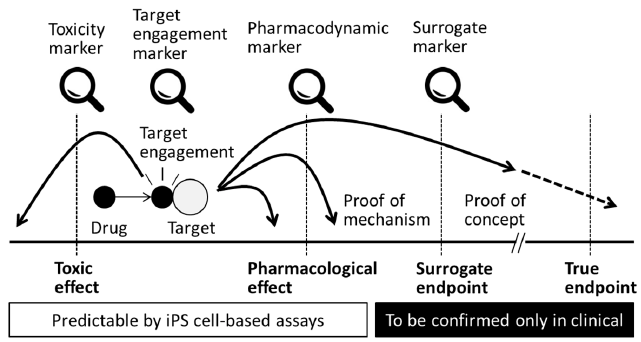
Figure 3. Biomarkers in efficacy and safety assessments. Application of in vitro assessment with iPS cell-based assay would be able to predict success or risk of a drug discovery project at an earlier